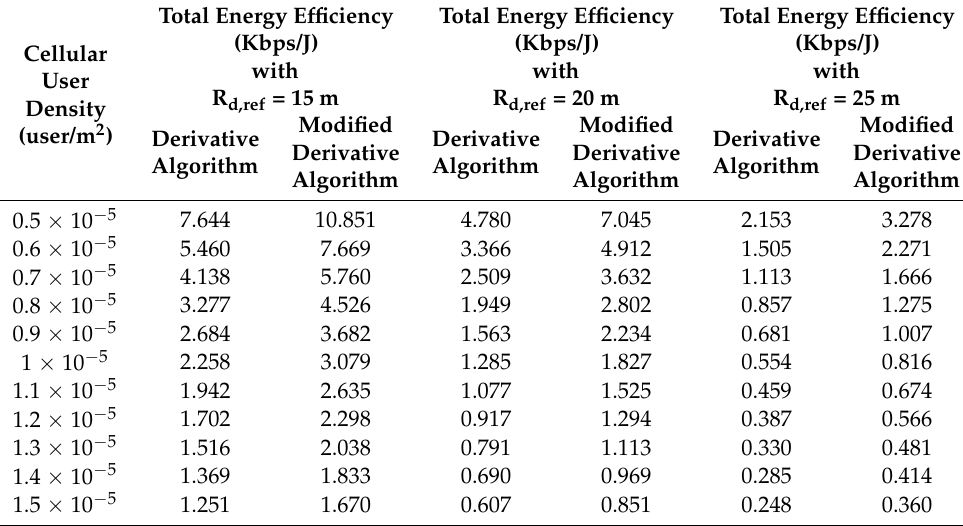
Table 5. Comparison of energy efficiency with the cellular density users (user/m 2